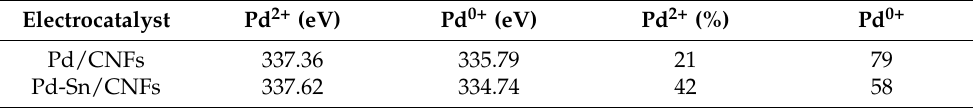
Table 2. BEs (eV) and relative percentage areas (%) of the two Pd 3d core level components.